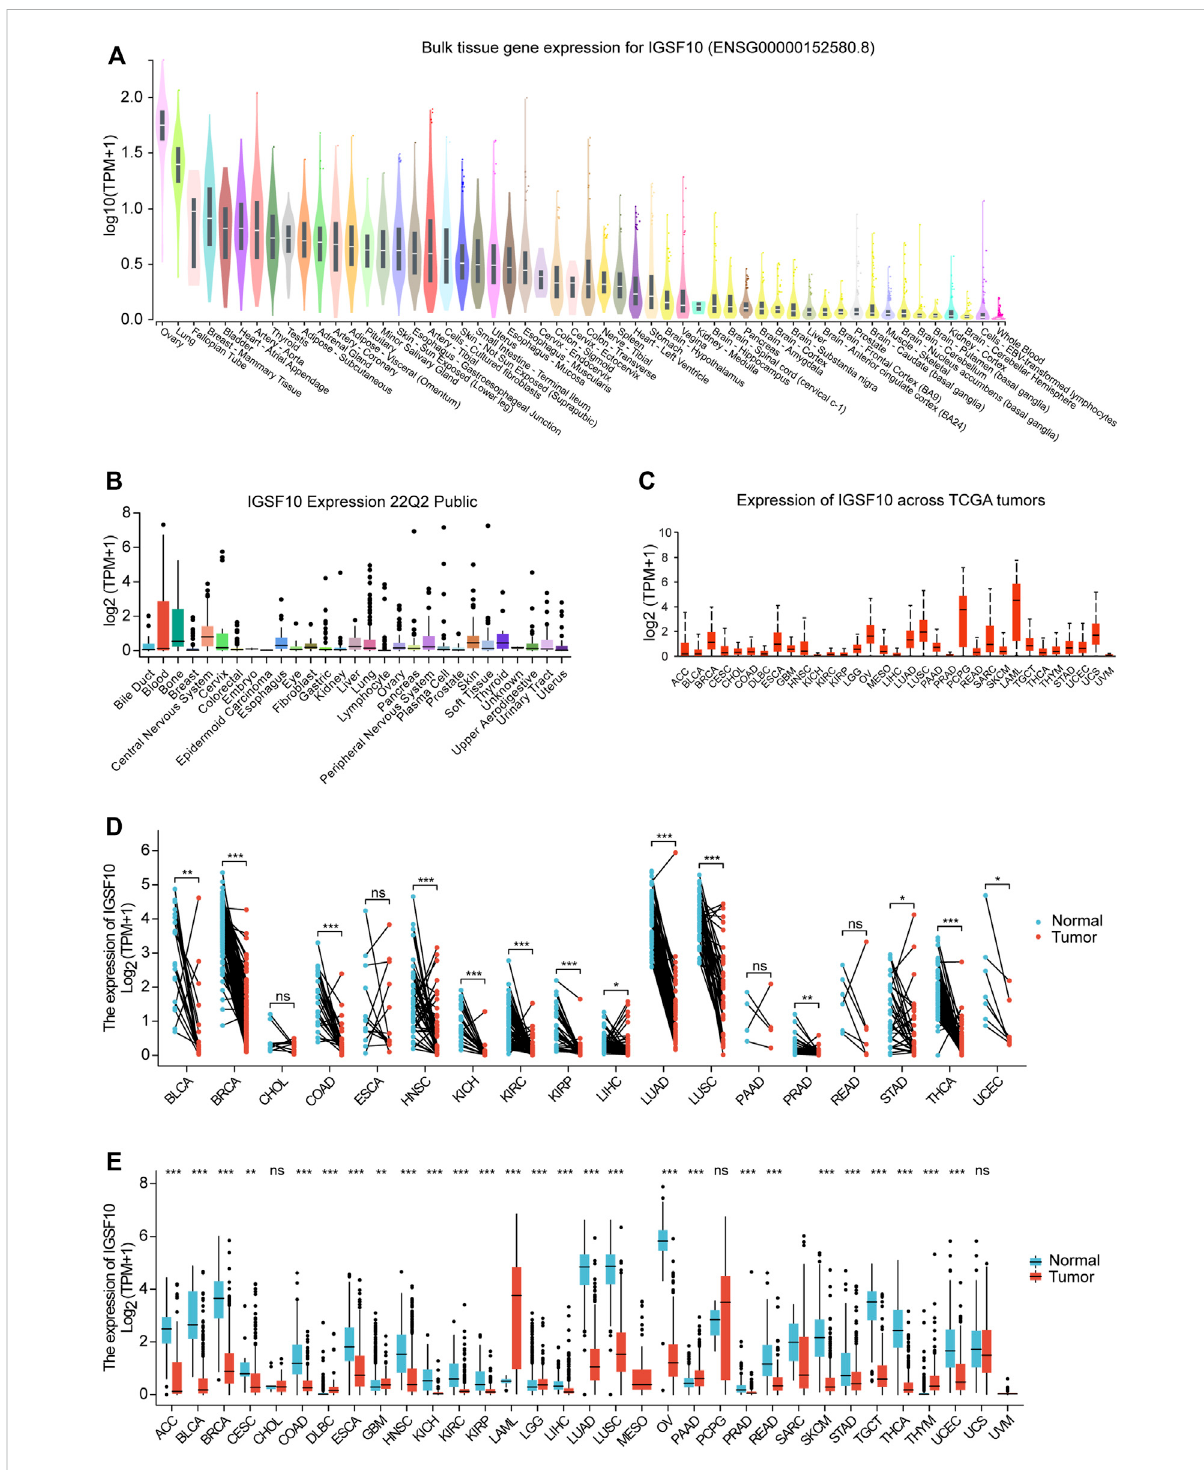
FIGURE 1 Differential expression of IGSF10 . (A) Expression of IGSF10 in normal specimens. (B) Expression of IGSF10 in a vary of cancer cell lines. (C) Expression of IGSF10 in 33 kinds of cancer. (D) Comparison of IGSF10 expression between tumor and paired normal specimens. (E) Comparison of IGSF10 expression between tumor and normal specimens. ns, p ≥ 0.05, * p < 0.05, ** p < 0.01, *** p <